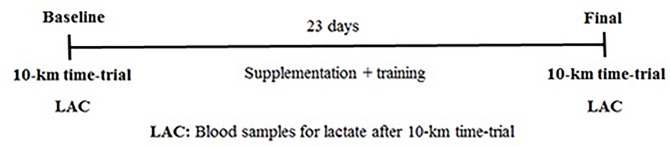
Experimental design.